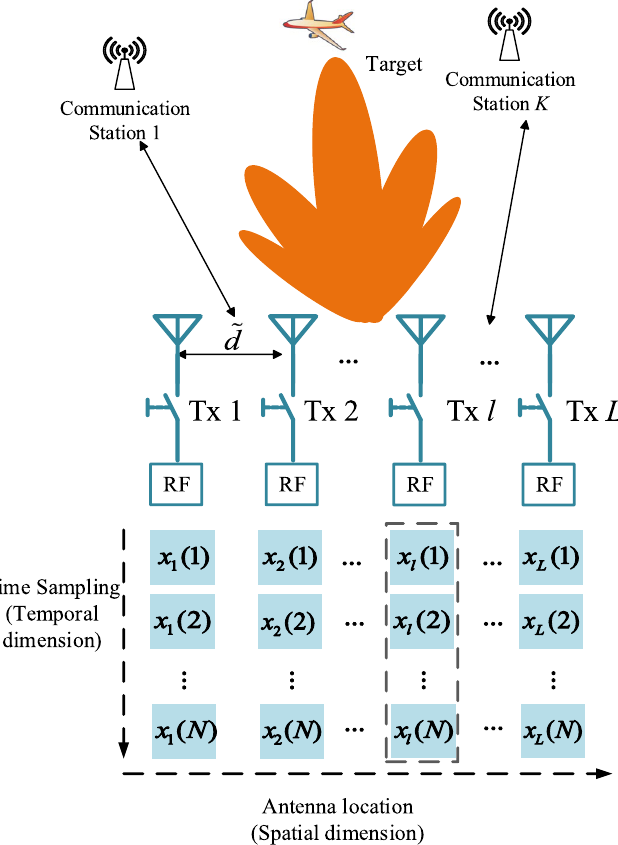
Fig. 1 MIMO array radar with designed waveforms and switchable antennas in coexistence with